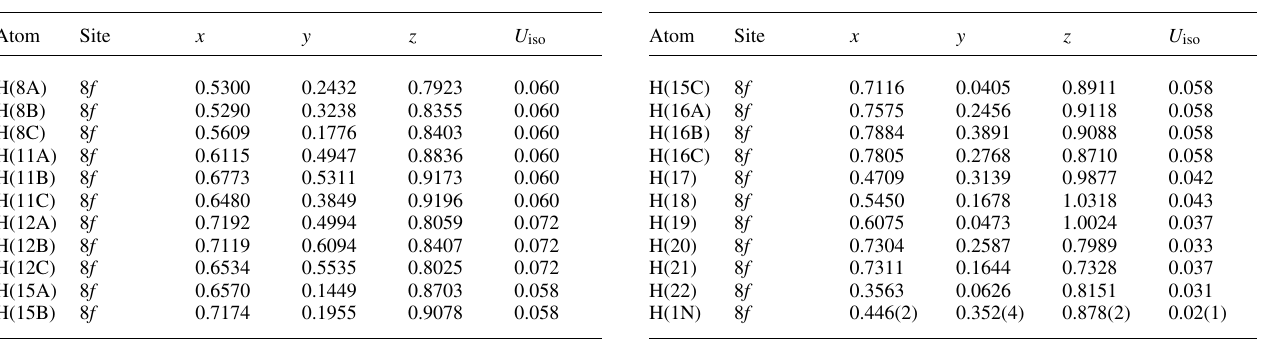
Table 3. Atomic coordinates and displacement parameters (in Å 2 )